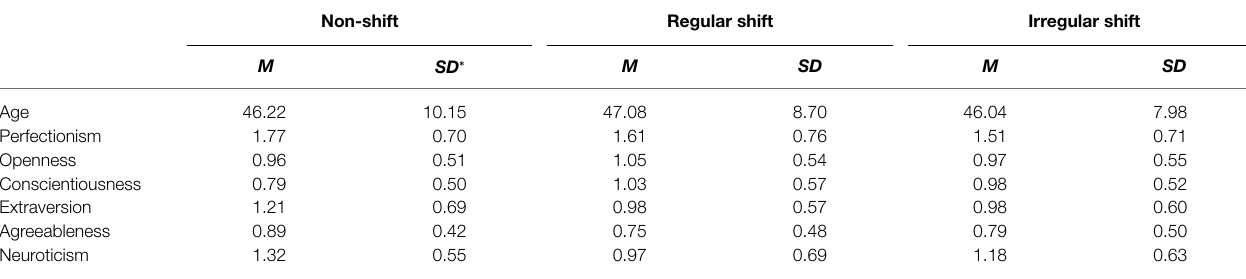
*SD, standard deviation.